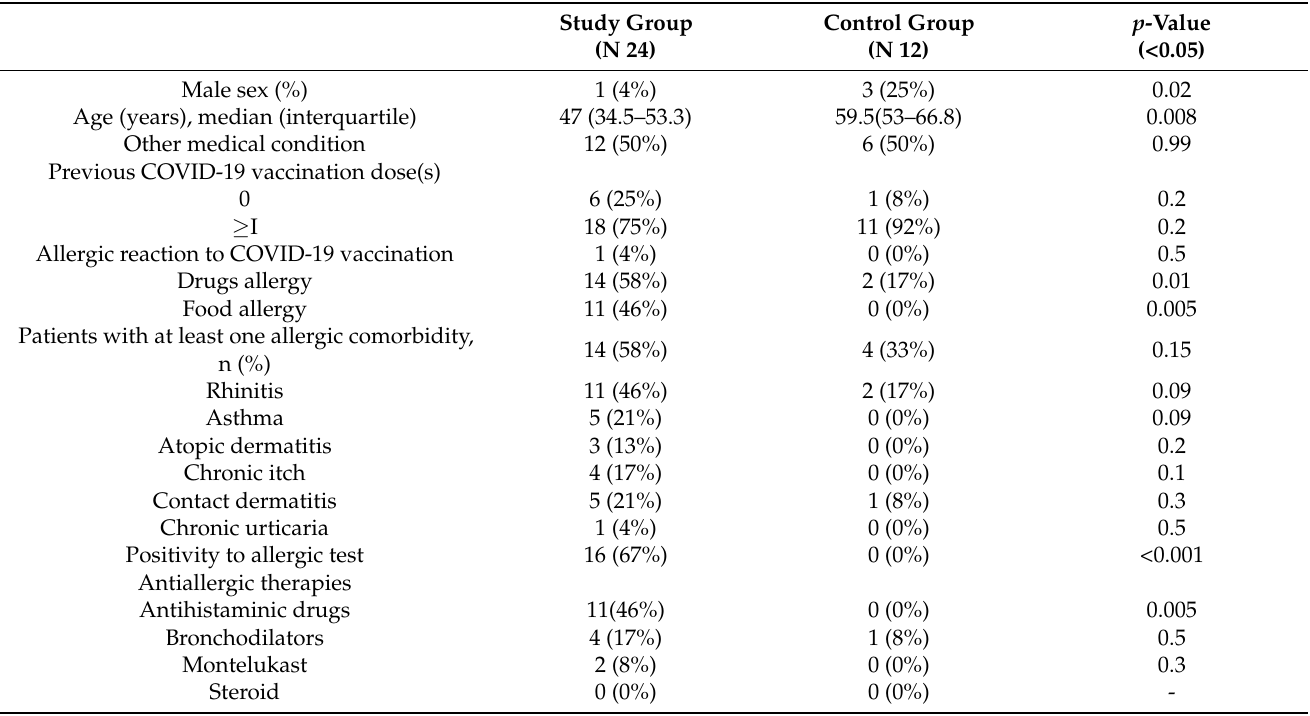
Figure 1. Flowchart illustrating the inclusion/exclusion of individuals in the study. Table 1. Baseline characteristics of participants.